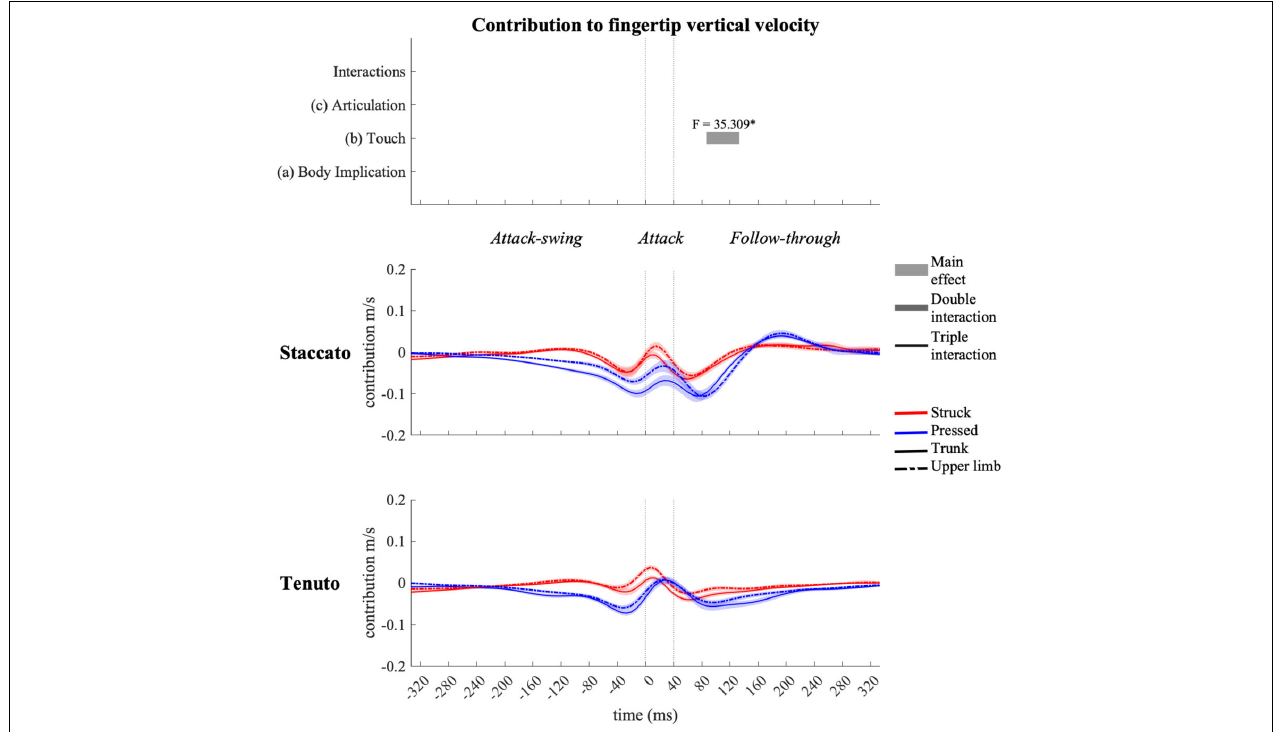
FIGURE 13 | Mean values (solid and dash-dotted lines) and 95% bootstrap confidence interval (shaded areas) of metacarpophalangeal joint angular contribution to endpoint vertical velocity during the three phases of the keystroke. Negative/positive values indicate contributions to downward/upward fingertip velocities. Top panels represent the results from the statistical parametric mapping of time-series values. * p -value ≤